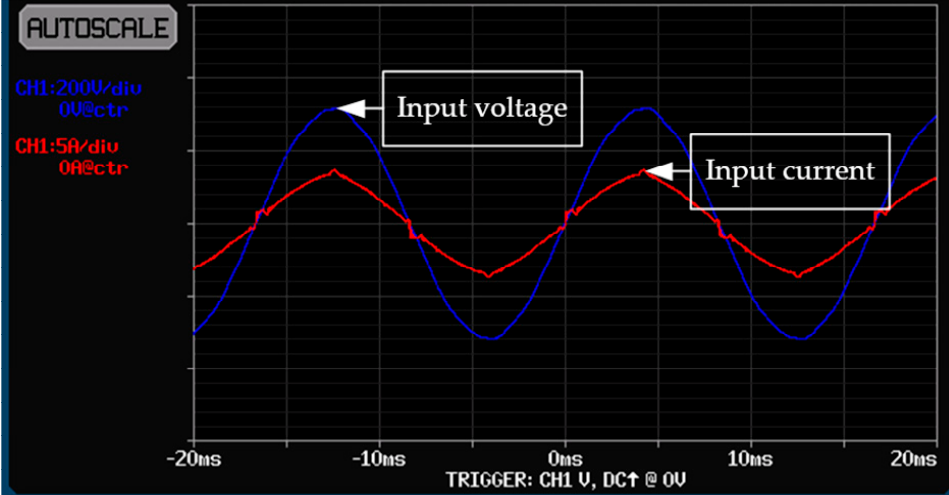
Figure 17. Input voltage and input current waveforms of the drive developed.